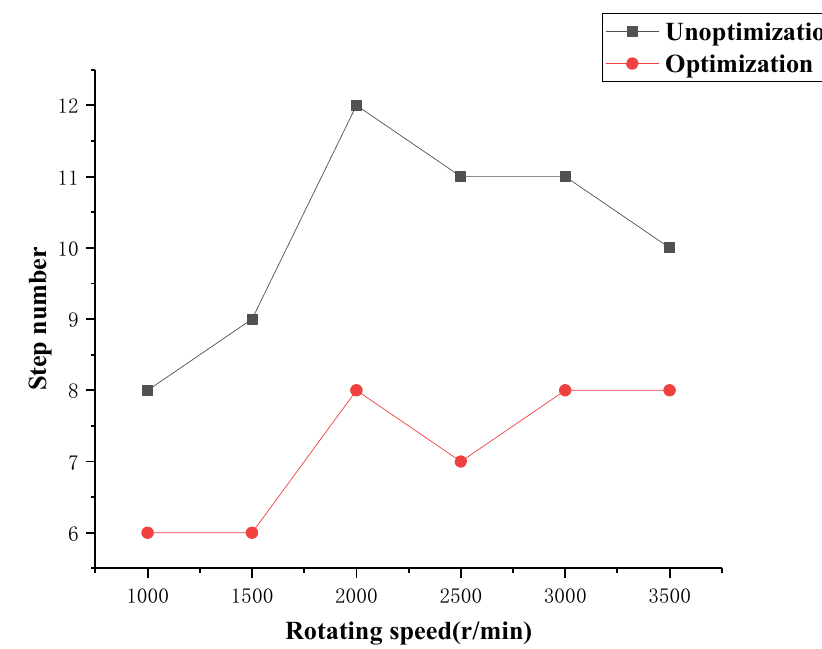
Figure 11. Number of mass block moves before and after optimization.